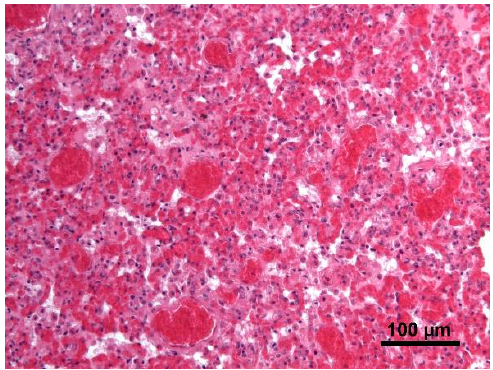
Figure 8. Lung. Severe pulmonary hyperemia and atelectasis; Hematoxylin and eosin stain, 20× magnification.